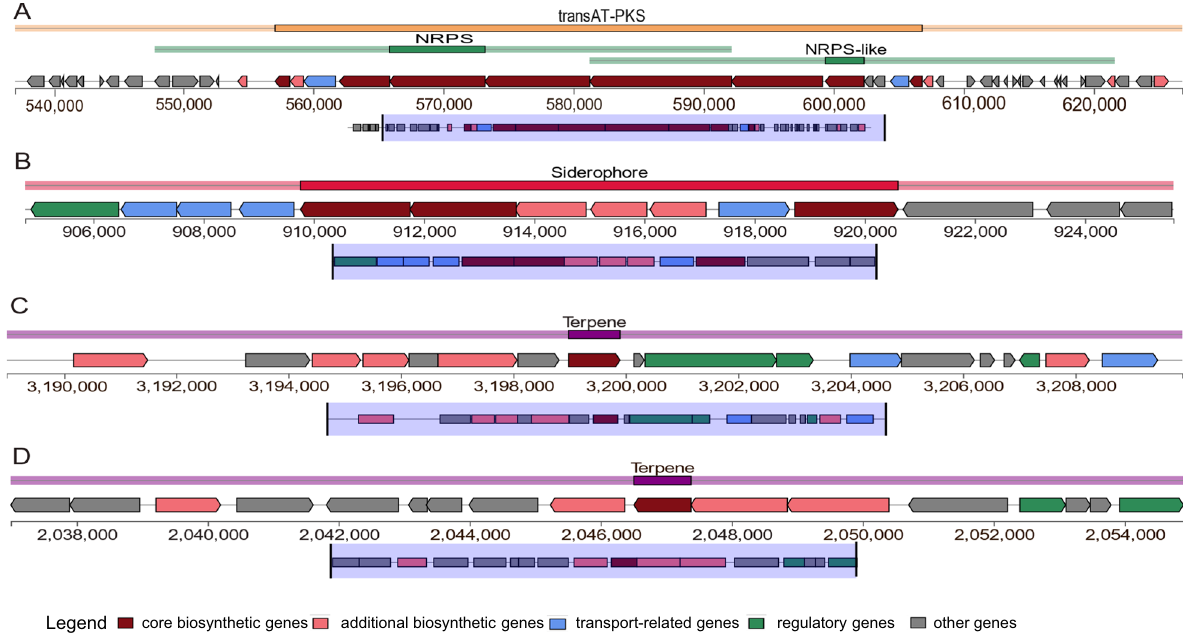
Fig. 3 Graphical representation of bacillaene, siderophores (staphylobactin), terpenes, and carotenoids, which are implicated in direct and indirect mechanisms of plant